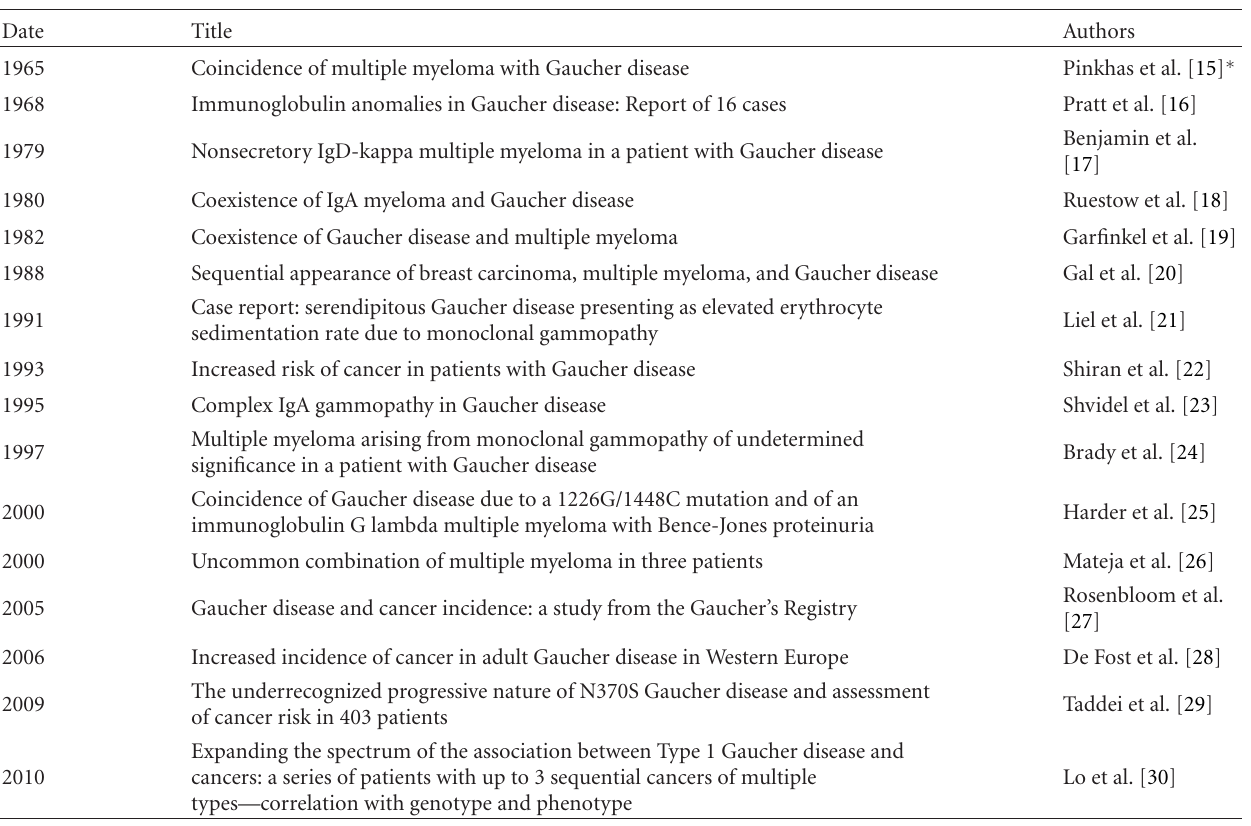
Table 1: Examples of reported associations of Gaucher disease with multiple myeloma. ∗ Note: the number in the bracket represents the reference number in the current Choy and Campbell